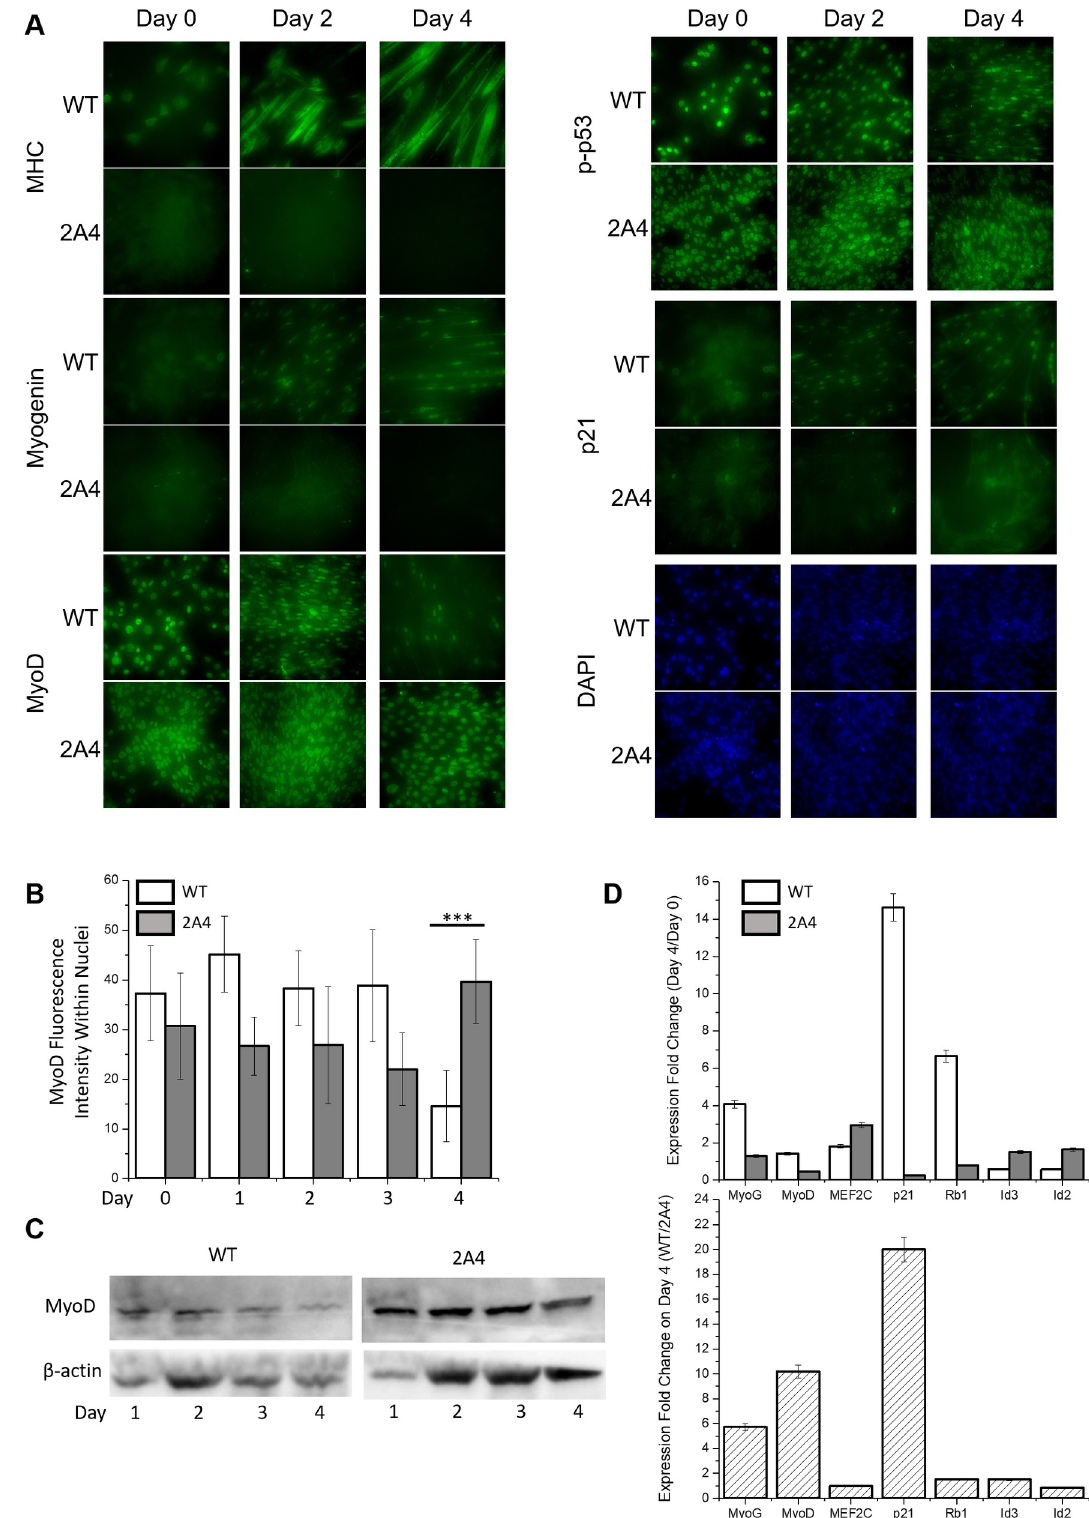
Fig 3. Expression and localization of myogenic regulatory factors in wild type and CRISPR-edited C2C12 myoblasts during myogenesis. (A) Immunofluorescence to determine the localization of MyoD, p-p53, p21, myogenin, and MHC in